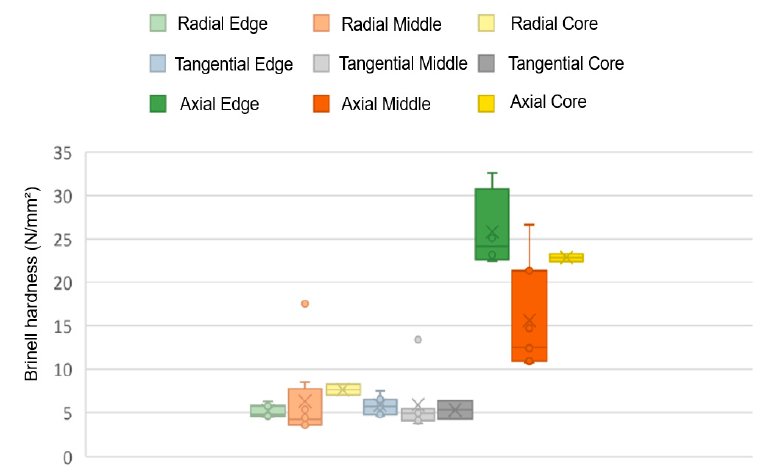
Figure 11. Brinell hardness in the axial, radial, and tangential section of Paulownia samples extracted from 10%, 50%, and 90% from the cross-section of Paulownia’s tree stem.